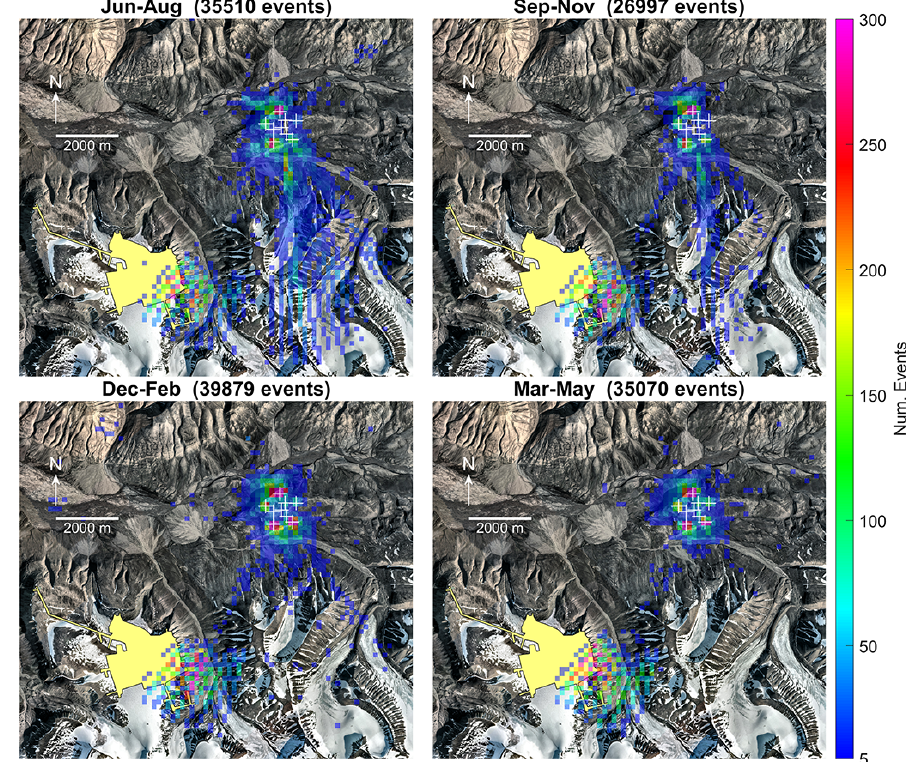
Figure 6. Spatially binned (150 × 150m) distribution of coherent-MFP-inferred seismic source positions plotted by season for events recorded between August 2004 and July 2021. Positions of SPITS seismometers are indicated by white crosses. The distal-event cluster corresponds with the location of underground mining operations at Gruve 7 (yellow polygon). Orthophoto © Norwegian Polar Institute (https://www.npolar.no/, 17 January